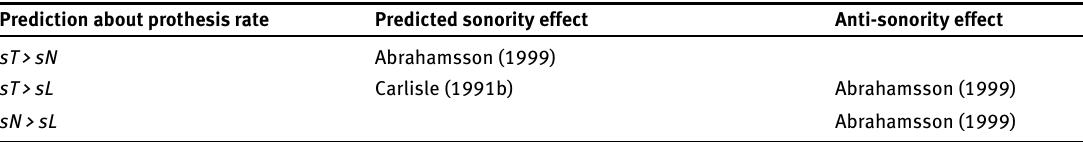
Table 2. Predicted vs. observed sonority effects in sC